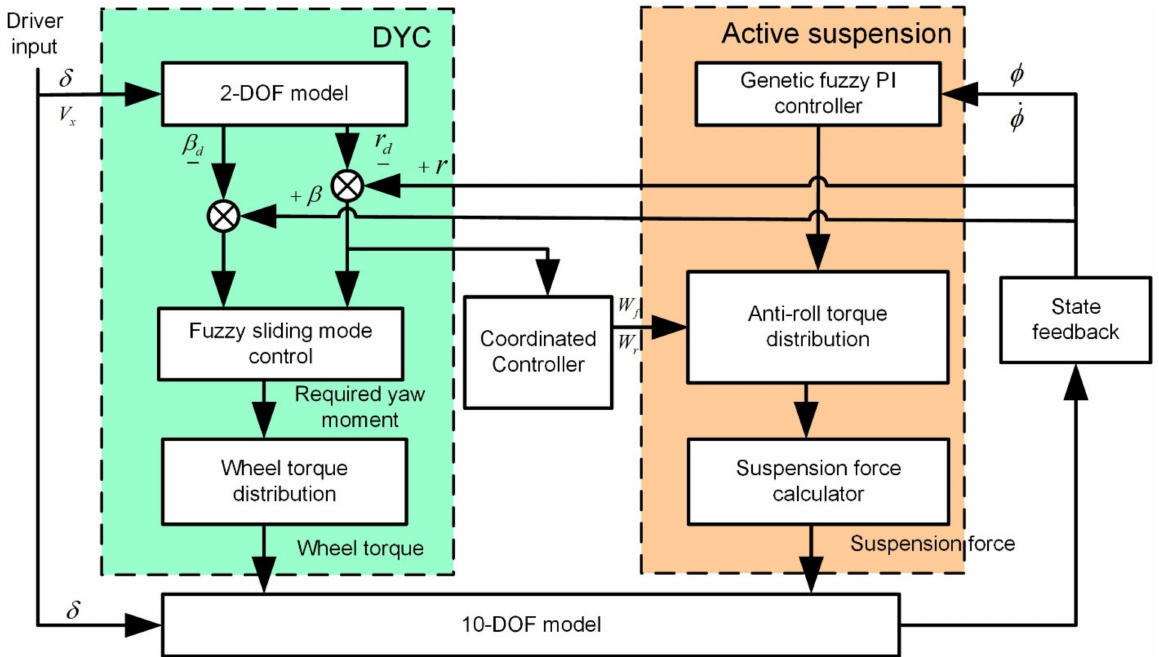
Figure 5. Principle framework of active suspension and DYC coordinated